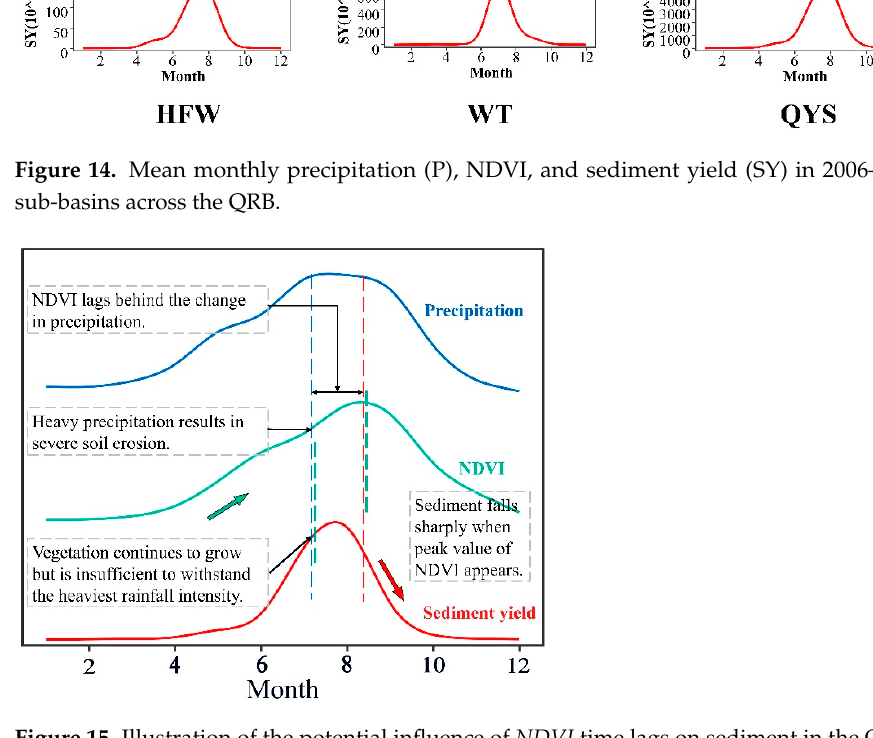
Figure 15. Illustration of the potential influence of NDVI time lags on sediment in the QRB.